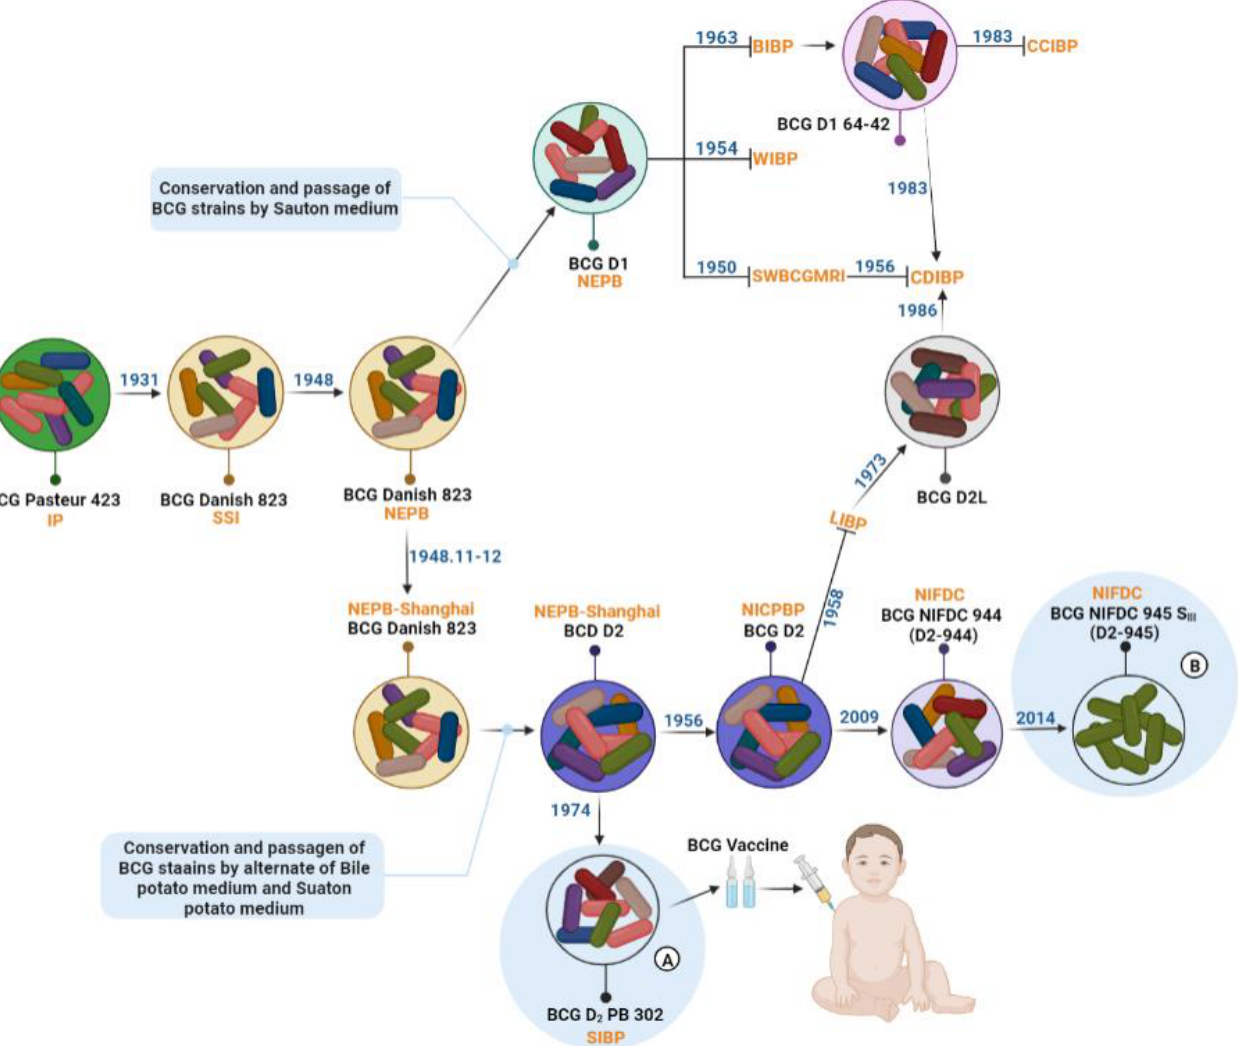
Figure 1. Chinese BCG genealogy and the movement of strains between labs. IP: Institut Pasteur, SSI: Statens Serum Institute, NEPB: National Epidemic Prevention Bureau, NEPB-Shanghai: National Epidemic Prevention Bureau-Shanghai, SWBCGMRI: Southwest BCG Manufacturing Research Institute, BIBP: Beijing Institute of Biological Products, WIBP: Wuhan Institute of Biological Products, CDIBP:Chendu Institute of Biological Products, CCIBP: Changchun Institute of Biological Products, LIBP: Lanzhou Institute of Biological Products, SIBP: Shanghai Institute of Biological Products, NICPBP: National Institute for the Control of Pharmaceutical and Biological Products, NIFDC: National Institute for the Control of Food and Drug. ( A ): BCG strains for modern production, ( B ): BCG single-cell clone strains.